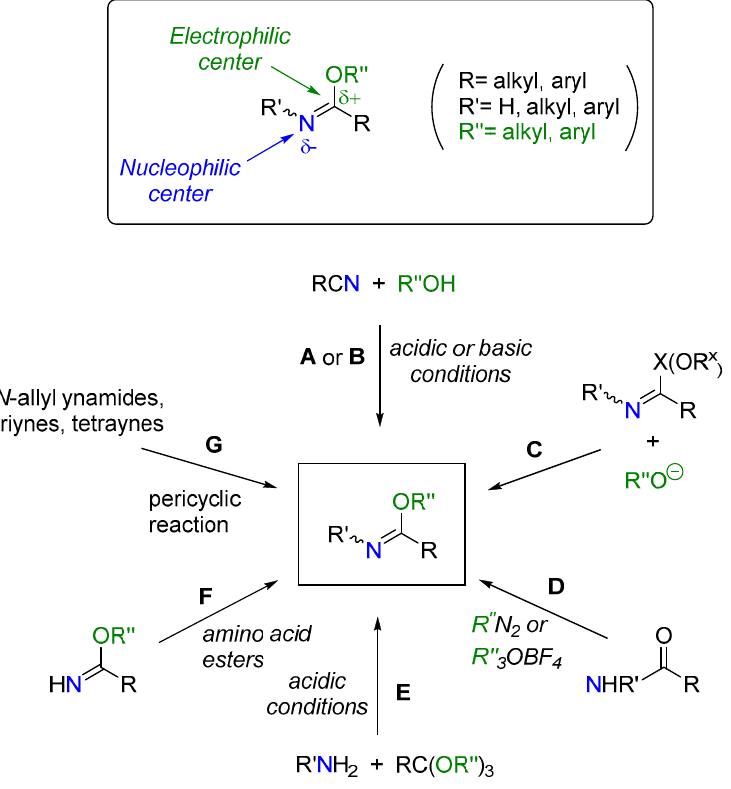
Figure 1. Synthetic methodologies (A–G) of imidates.